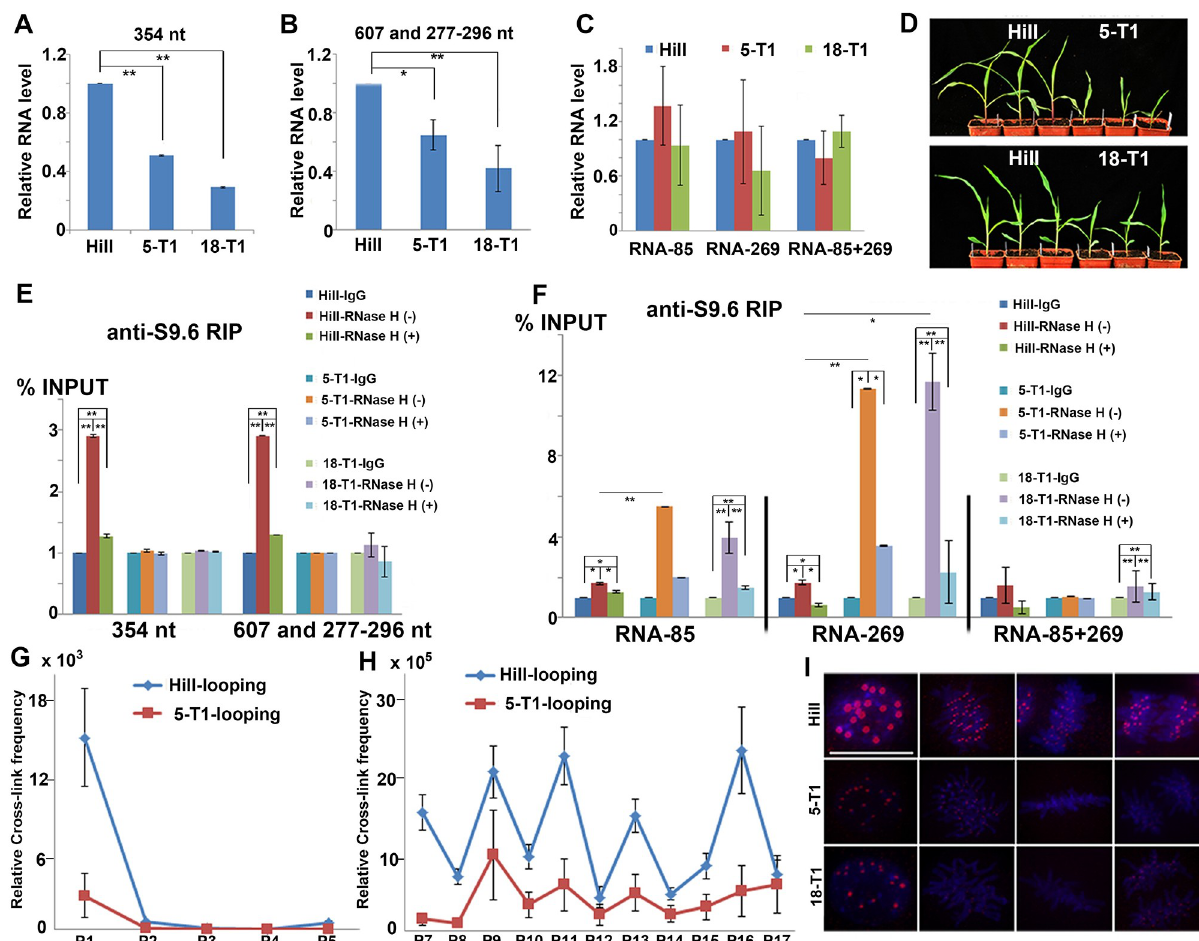
Fig 4. Decreased chromatin loops and CENH3 localizations in the CRM1 regions of the RNAi plants. (A and B) RT-qPCR analysis of the levels of the 354-, 607-, and 277- to 296-nt circular RNAs in the T 1 generation of RNAi plants 5 and 18, with HiII as the control. (C) Level of linear RNAs (RNA- 85, RNA-269, and RNA-85+269) in the T 1 generation of RNAi plants, with HiII as the control. (D) Seedlings of the T 1 RNAi plants. (E) Anti-S9.6 RIP quantification of R-loops in the circular CRM1 RNAs in the T 1 RNAi plants. (F) Anti-S9.6 RIP quantification of R-loops in the linear RNAs in the T 1 RNAi plants. (G and H) 3C-qPCR analysis of the chromatin interactions inside a single CRM1 element (G) and between two CRM1 elements (H) in the T 1 generation of RNAi line 5. Data were normalized to the cross-link frequencies of the 3C control template composed of Dpn II-digested and ligated centromeric BAC and the internal reference SAM . The primers used were the same as in Fig 3. (I) CENH3 signals in the T 1 RNAi plants. Blue indicates DAPI. Red indicates the CENH3 signals. Bar = 10 μ m. In (A–C,) and (E–H), the columns and error bars represent the relative value and standard error of the means ( n = 3). In (A–C), (E), and (F), Actin was used as an internal reference gene, the P values were determined using a Student t test: � P < 0.05, �� P < 0.01. The data underlying this figure can be found in S1 Data. 3C, chromatin conformation capture; BAC, bacterial artificial chromosome; CENH3, centromeric H3 variant; CRM1, centromeric retrotransposon; IgG, Immunoglobulin G; RIP, RNA immunoprecipitation; RNAi, RNA interference; RT-qPCR, reverse transcription quantitative